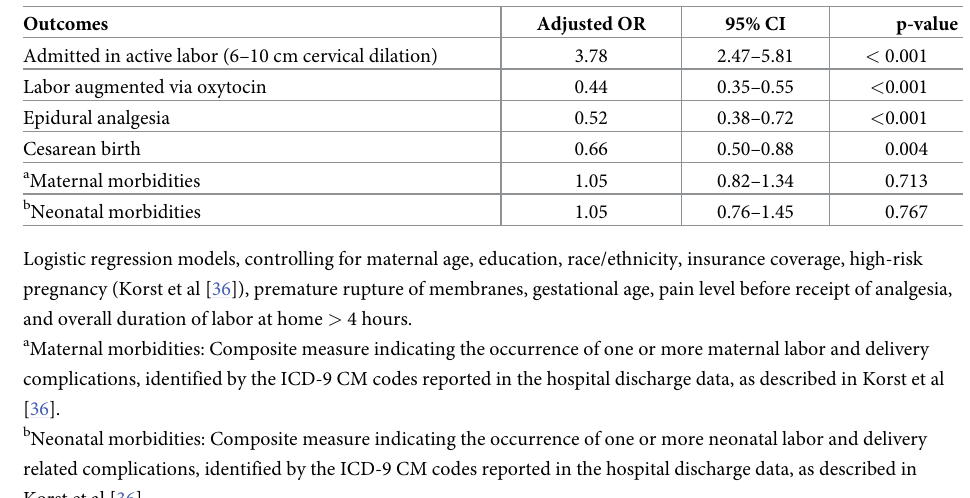
Table 2. Associations between timing of hospital admission (comparing early admits to later admits) and the six study outcomes (n =